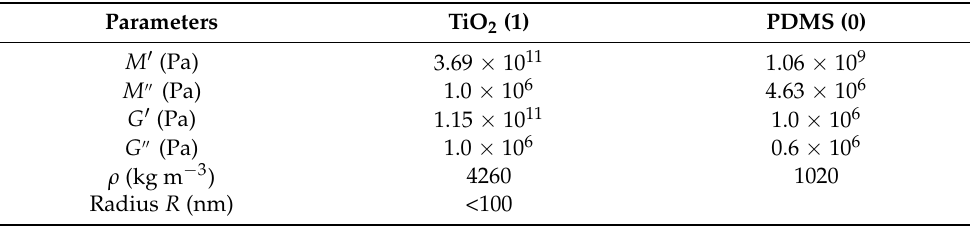
Table 1. Properties of PDMS and TiO 2